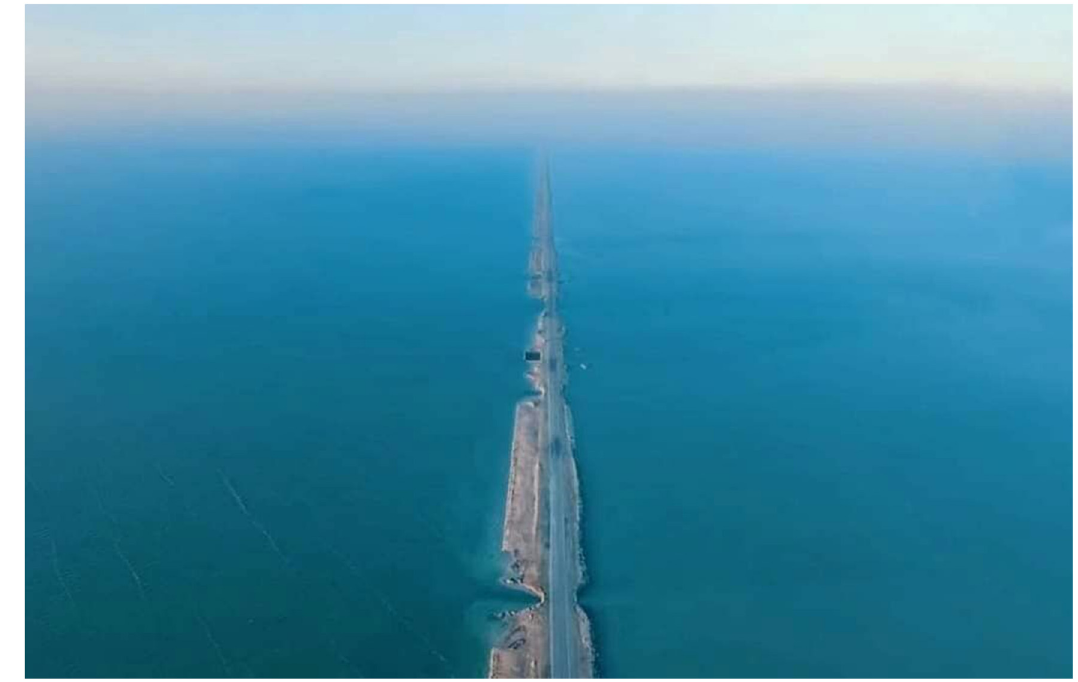
Figure 1: Seasonal collected water in the Al - Shewicha trough after sitting of sediment load, Wasit Province, Iraq.